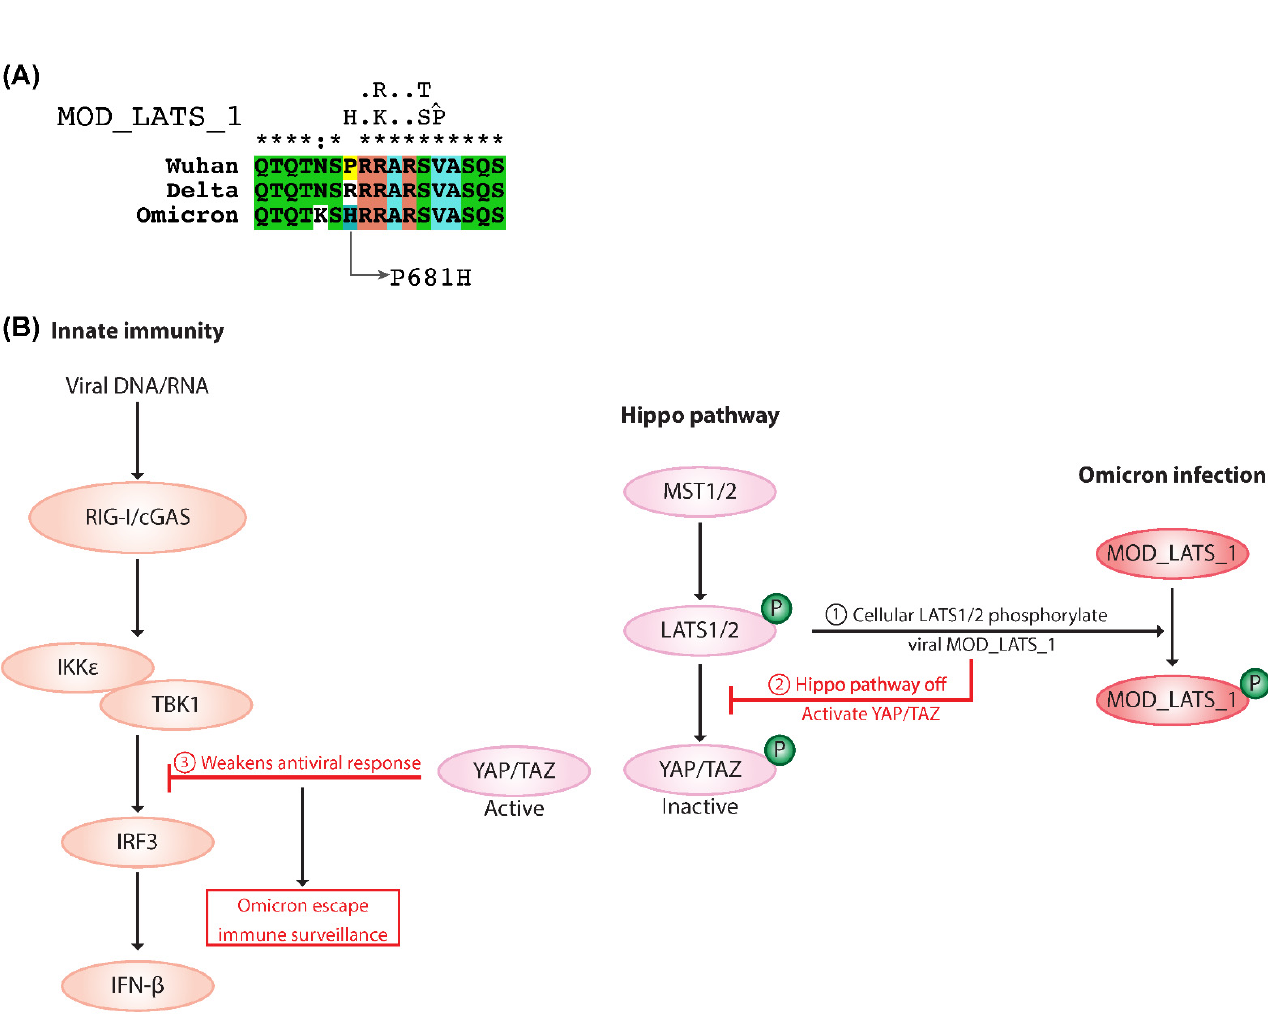
Figure 5. Schematic representation of the Hippo signaling pathway and Omicron MOD_LATS_1 intervention. ( A ) Snapshot of the multiple sequence alignment of spike proteins from Wuhan, Delta, and Omicron along with the specific mutations in the Omicron that lead to the emergence of the SLiMs. ( B ) Modulation in the Hippo signaling pathway during Omicron infection. When the Hippo signaling pathway is active/on, YAP/TAZ proteins become phosphorylated by LATS1/2 kinases and remain in inactive form. However, during Omicron infection, cellular LATS1/2 kinases phosphorylate viral MOD_LATS_1 leaving active cytoplasmic YAP/TAZ, which can negatively regulate immune response and facilitate Omicron